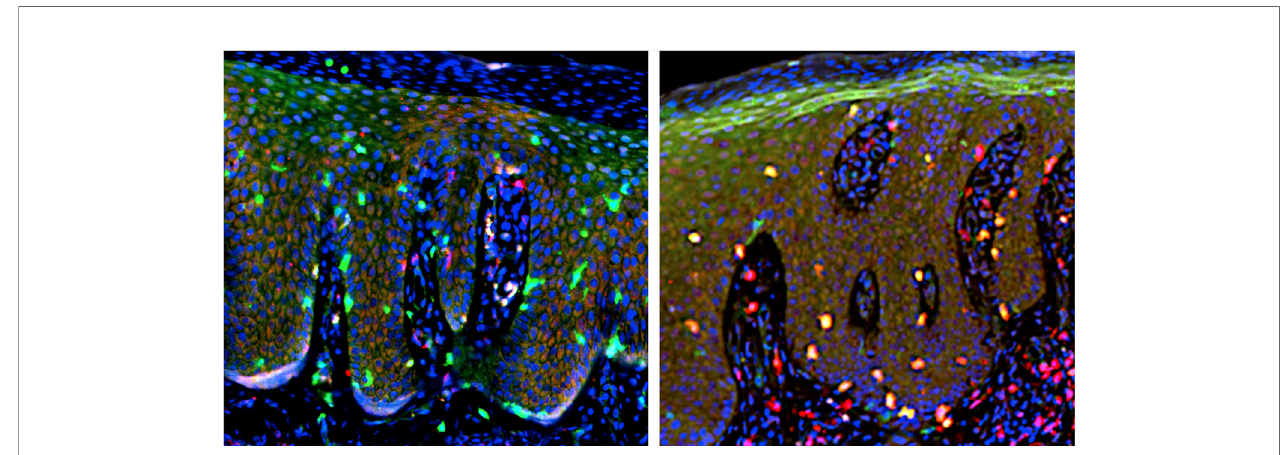
FIGURE 6 | Double immuno fl uorescent staining. Left: CD4 (red) and CD103 (green). Right: CD8 (red) and CD103 (green). Merged yellow color (right) indicate cells positive for both CD8 and CD103, representing T